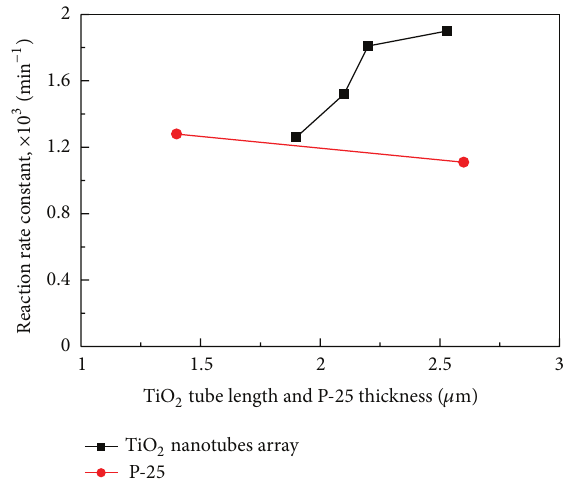
Figure 9: Photocatalytic reaction rate constants of TiO 2 nanotube arrays film and P-25 film as a function of film thickness.